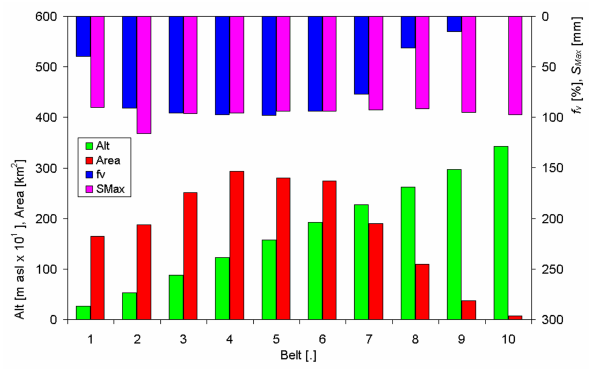
Fig. 3. Main features of the selected altitude